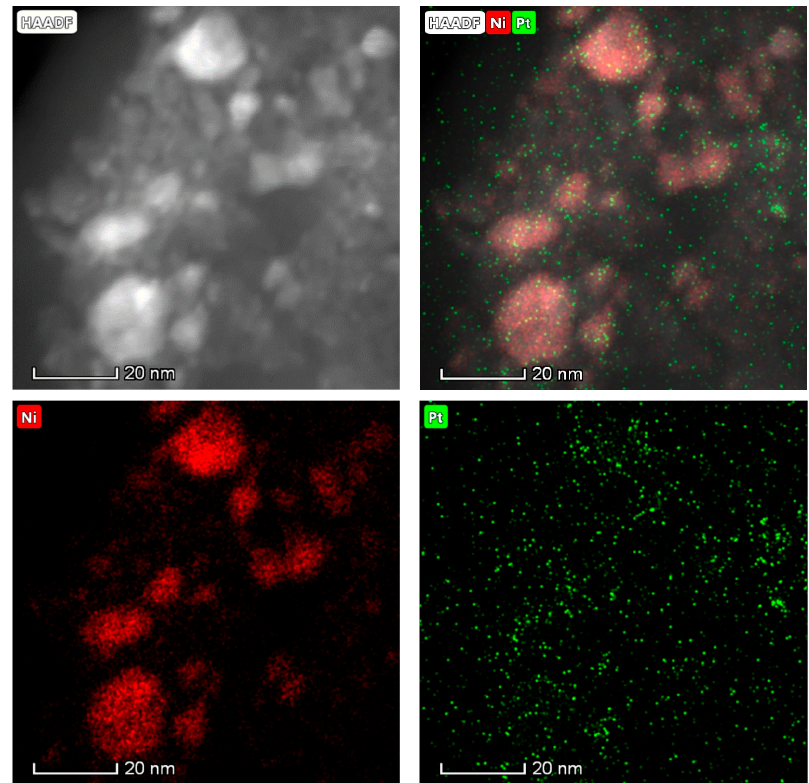
Figure A4. High-angle annular dark-field (HAADF) scanning transmission electron micrograph ( top left ) of a region within the spent 20% Ni-0.5% Pt/Al 2 O 3 catalyst and the corresponding elemental maps of both Ni and Pt ( top right ), Ni only ( bottom left ), and Pt only ( bottom right ).